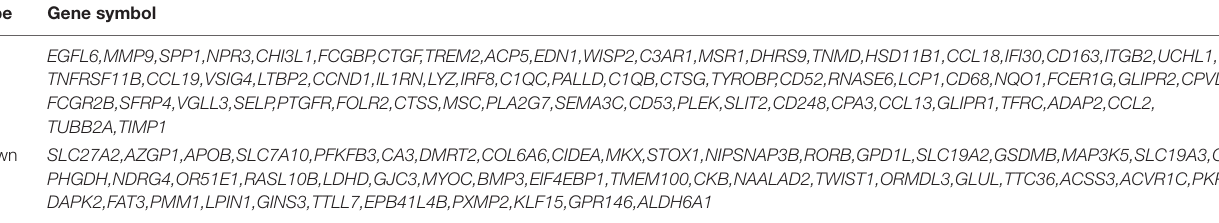
TABLE 2 | Co-expression of differential genes.